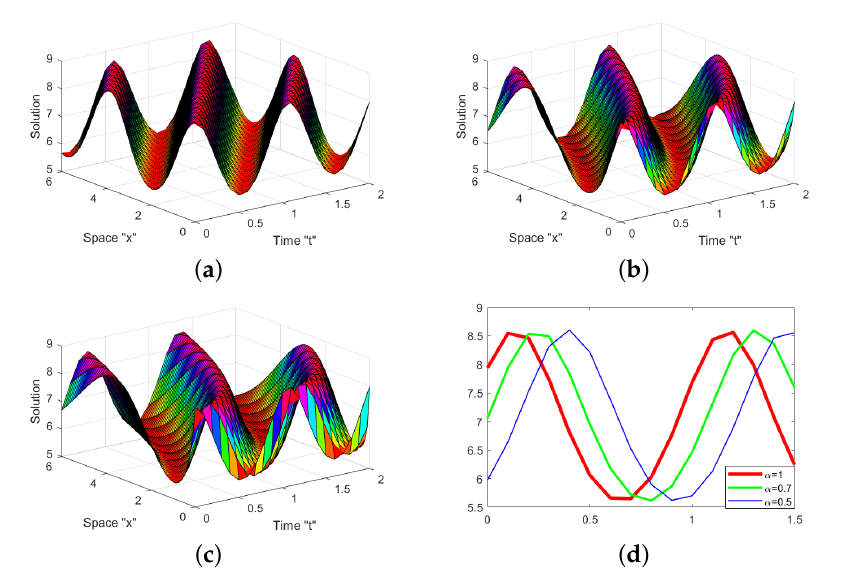
Figure 3. For Equation (33), ( a – c ) with parameters k = − 1, σ = 0, λ = − 4, indicate the 3D profiles and ( d ) denotes the 2D plot for different values of α at t = 1.5 and there is no overlap between the curves of the solution. ( a ) α = 1, β = 0 ( b ) α = 0.7, β = 0.9 and ( c ) α = 0.5, β =